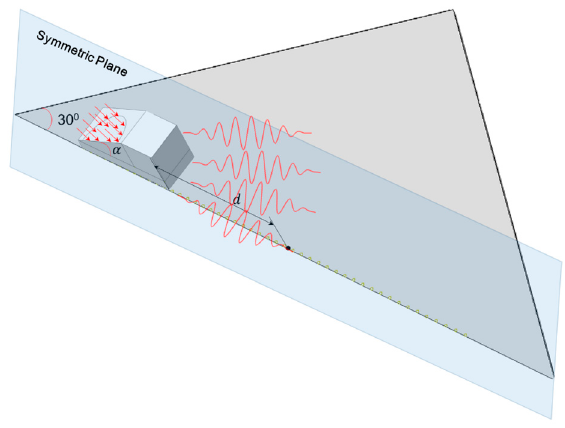
Figure 6. Schematic of the 3-D simulation model for the mode pair S 0 -S 0 .